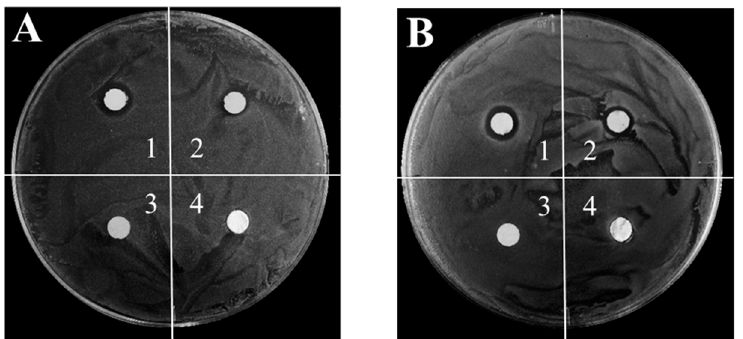
Table 1. The size of the inhibition zones of four samples against the Gram-positive bacteria MRSA and Gram-negative bacteria E. coli (n = 5).